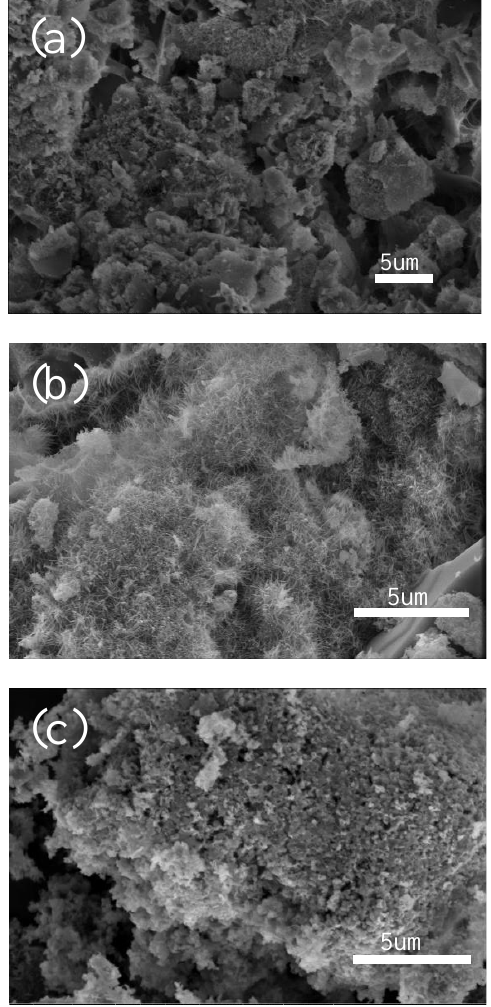
Figure 5. SEM images of whiskers prepared by adding ( a ) 5%, ( b ) 10%, ( c ) 15% of Na 2 SO 4.